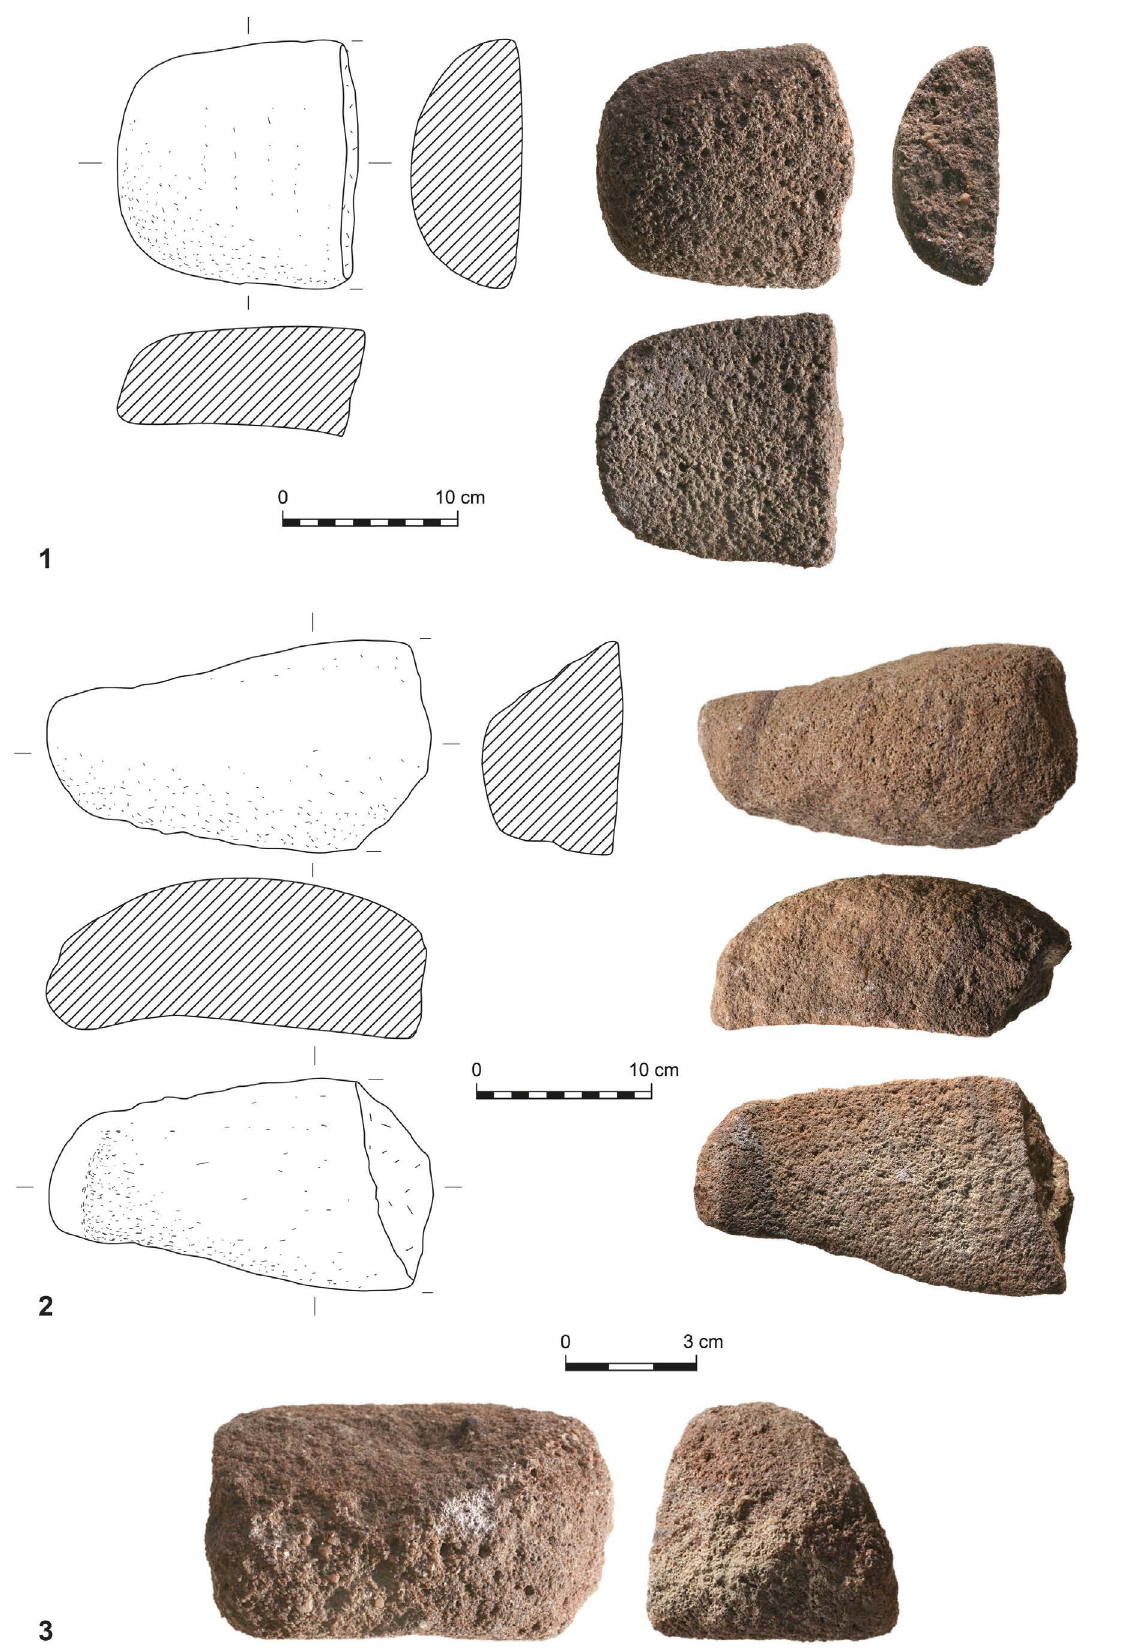
Figure 7. Grinding stones from Site 34. (1) B. 27 (survey): lower (?) “loaf-shaped” grinding stone; (2) B.15 (survey): upper (?) grinding stones with overhanging terminals, held with two hands; (3) B.28 (survey): upper grinding stone, held with one